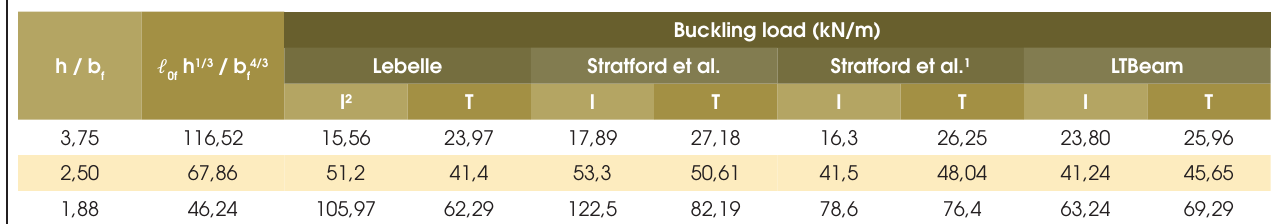
Table 7 – Buckling load of I-section beams for flange width variation